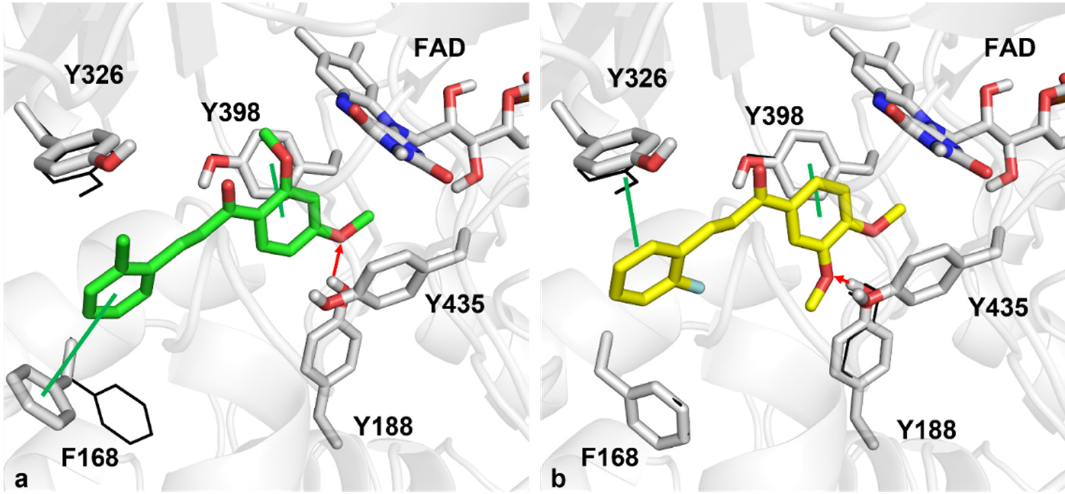
Figure 6. Docking analysis of DM2 ( a ) and DM18 ( b ) for the best poses towards MAO-B. Green and yellow sticks represent DM2 and DM18 , respectively. Black wireframes depict MAO-B side chains in the original positions. Green lines and red arrows indicate Pi-Pi contacts and hydrogen bonds, respectively.